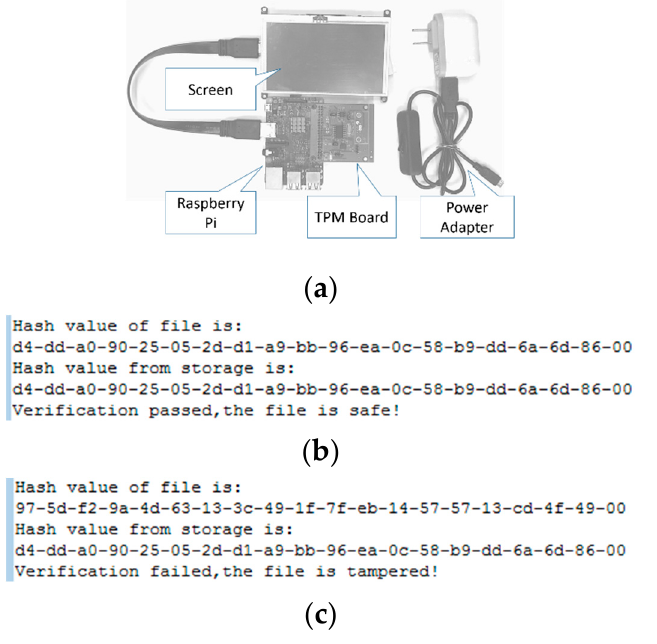
Figure 10. Experiment device for TPM module ( a ) and integrity measurement results ( b,c ).